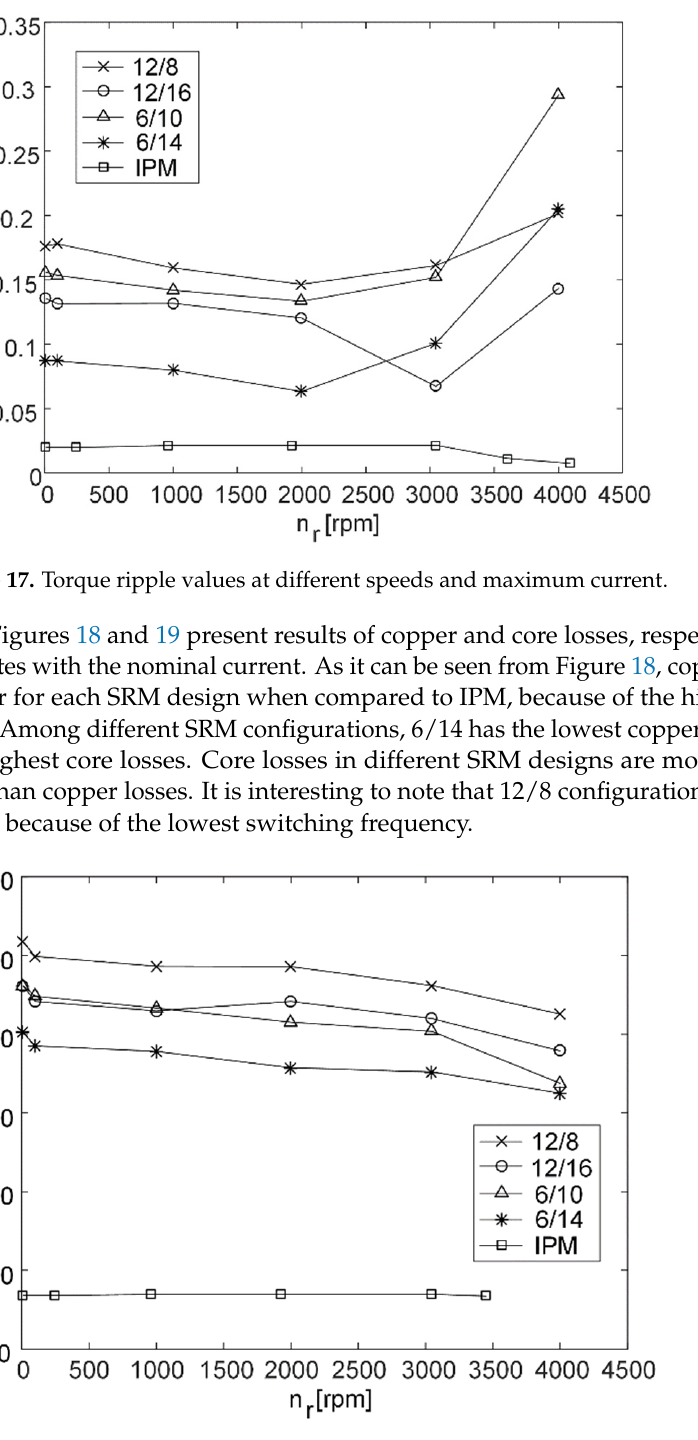
Figure 18. Copper losses at nominal current operation.